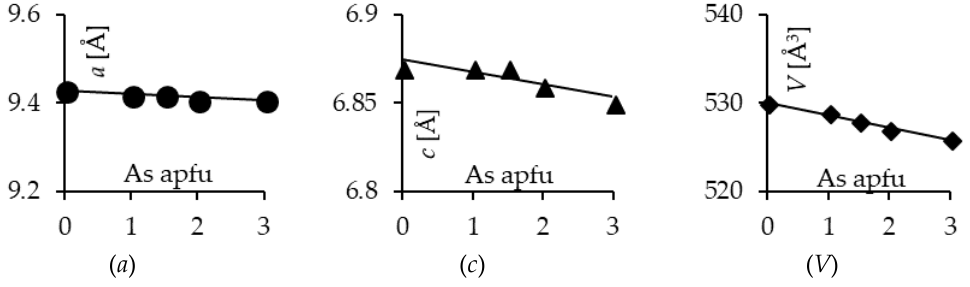
Figure 3. Linear variation of the unit cell parameters a , c , and V in the JBM–HAP solid solution series.